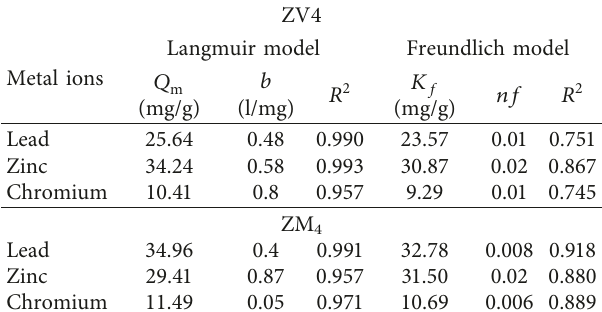
Figure 12: Freundlich isotherm showing the variation of ln Table 3: Langmuir and Freundlich isotherm parameters for the adsorption of lead, zinc, and chromium onto ZV4 and